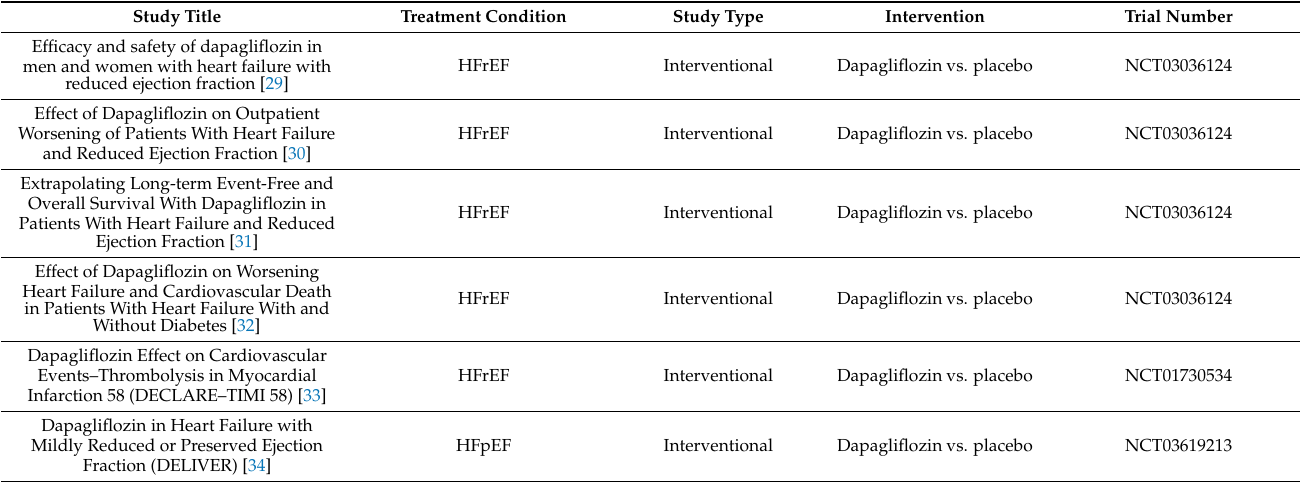
Table 2. List of clinical trials evaluating the effect of dapagliflozin on cardiovascular events in patients with heart